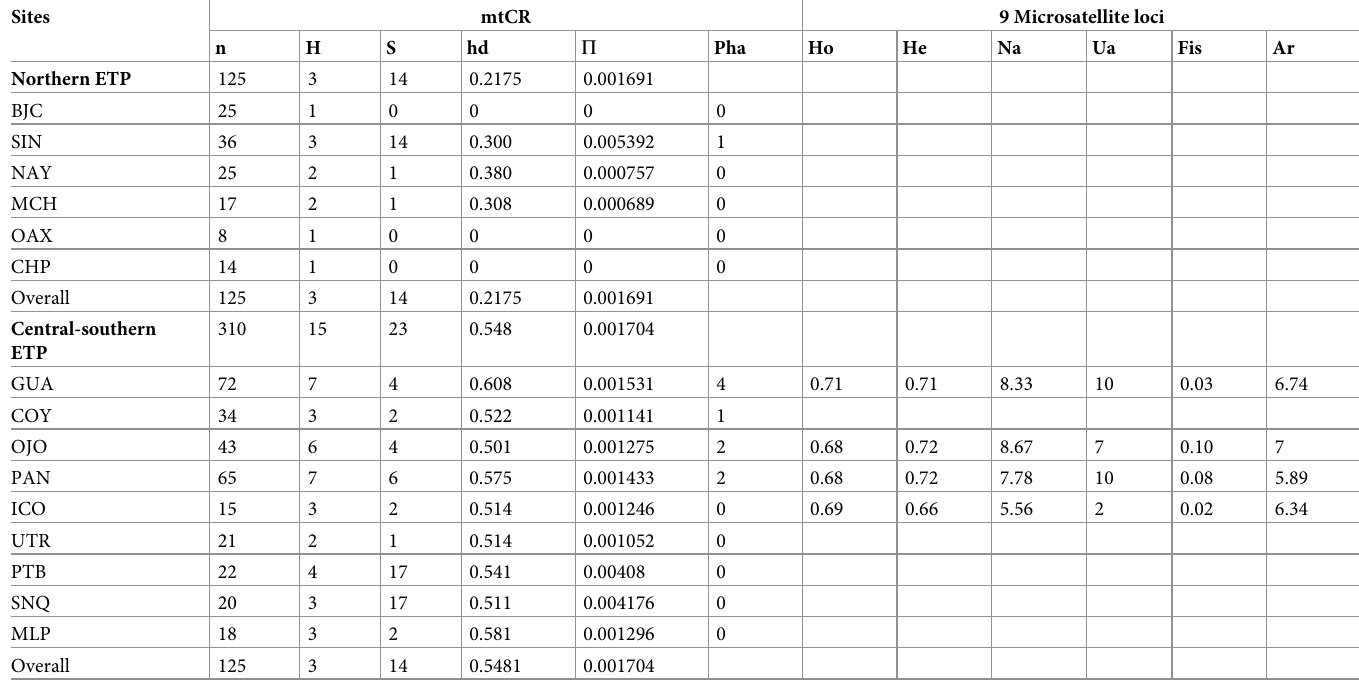
Table 1. Genetic diversity indices for the mitochondrial control region and 9 microsatellite loci for Sphyrna lewini individuals in the Eastern Tropical Pacific.